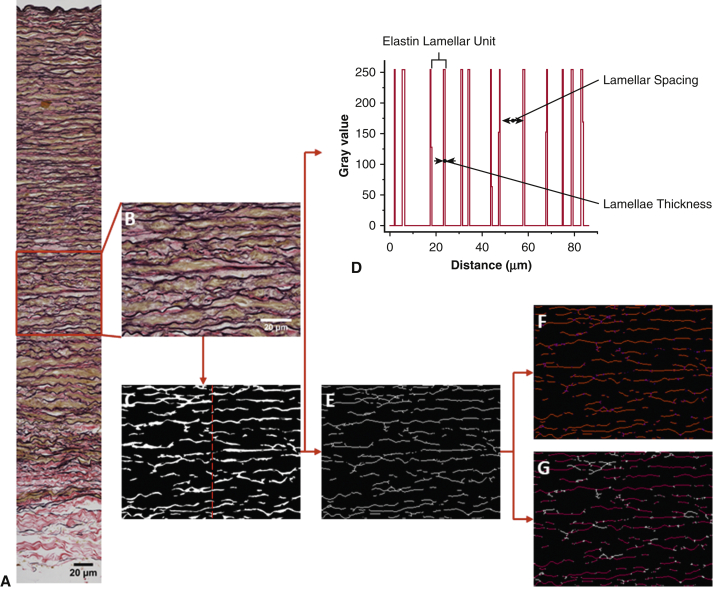
Image processing procedure to obtain microstructural properties of elastin. A, Representative stitched Verhoeff Van Gieson–stained aortic wall image. B, Middle media segment of the tissue highlighted was used in pixel classification. Pixel classifier was trained using 6 images before (C) simple segmented mask image was exported. Typically to quantify elastic lamellae properties in the media, a line was drawn at the area of interest like the red central line drawn in (C) to produce (D) a plot profile, and subsequently the number of lamellar units, lamellar spacing, and elastic lamellae thickness were measured. To quantify elastin segments over the entire tissue cross-section, in E, a downscaled and skeletonized image of the mask image was required. Our in-house macro script identifies F, the number of elastin segments (red lines separated out with purple ends) and G, the length of elastin segments (between the white ends). All images were taken at 40× magnification. Scale bar: 20 μm.